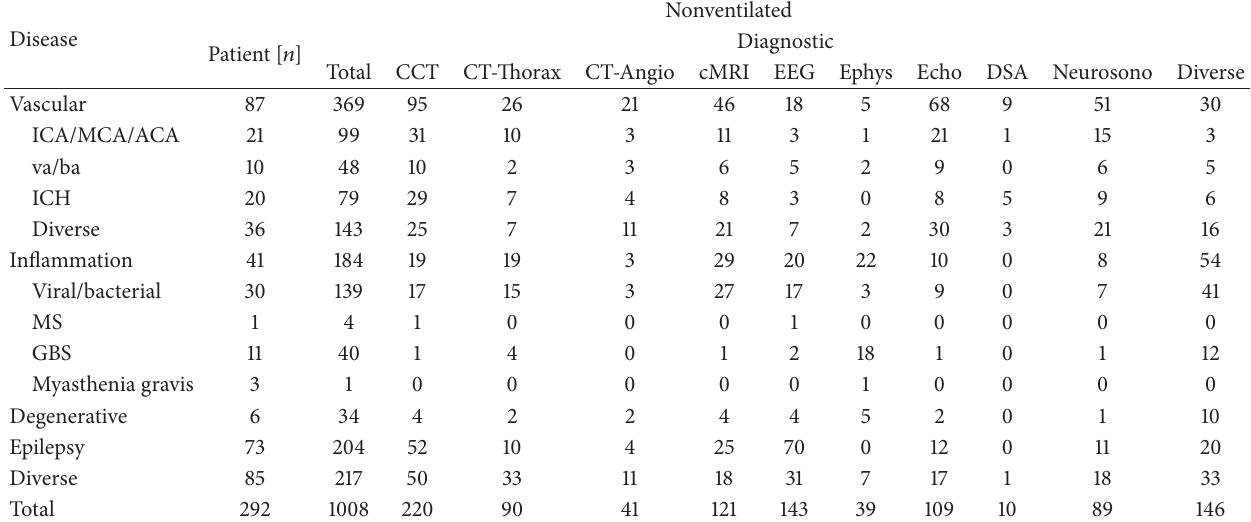
Table 4: Diagnostic procedures in nonventilated patient